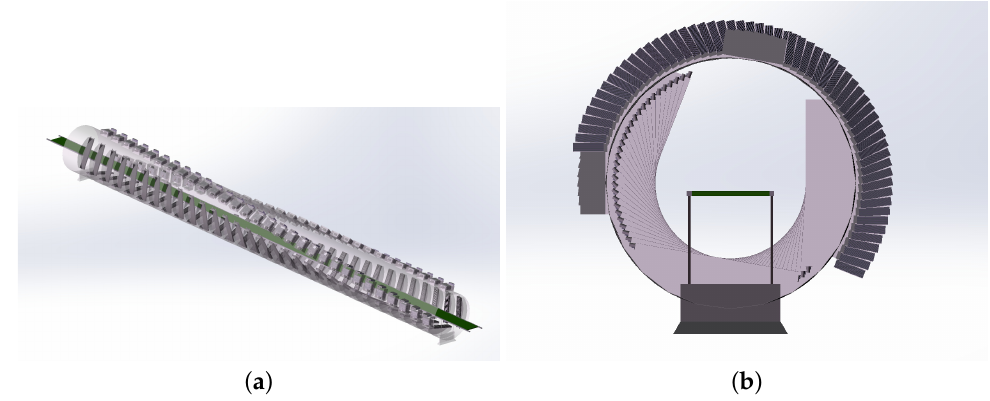
Figure 4. Overall view and side view of the system. ( a ) Overall view of the system; ( b ) side view of the